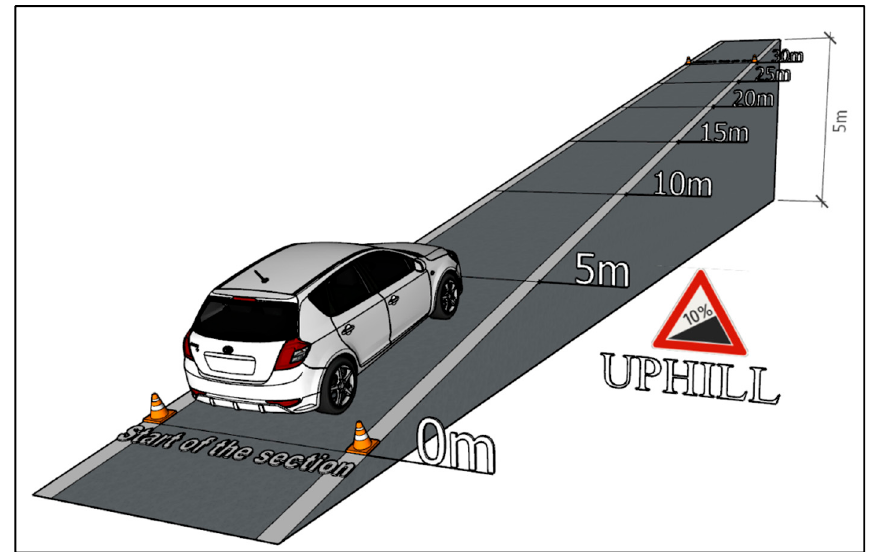
Figure 4. Measurement Visualization—Uphill [author via Sketchup].